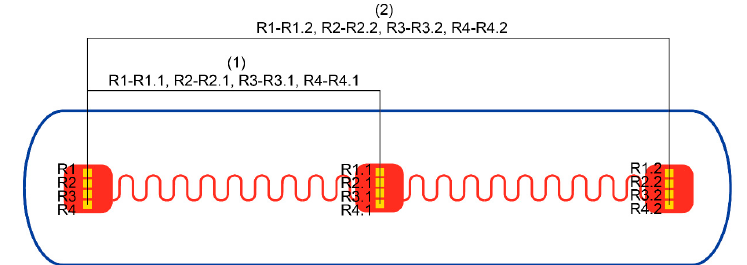
Figure 6. Resistance measuring points on the sample.